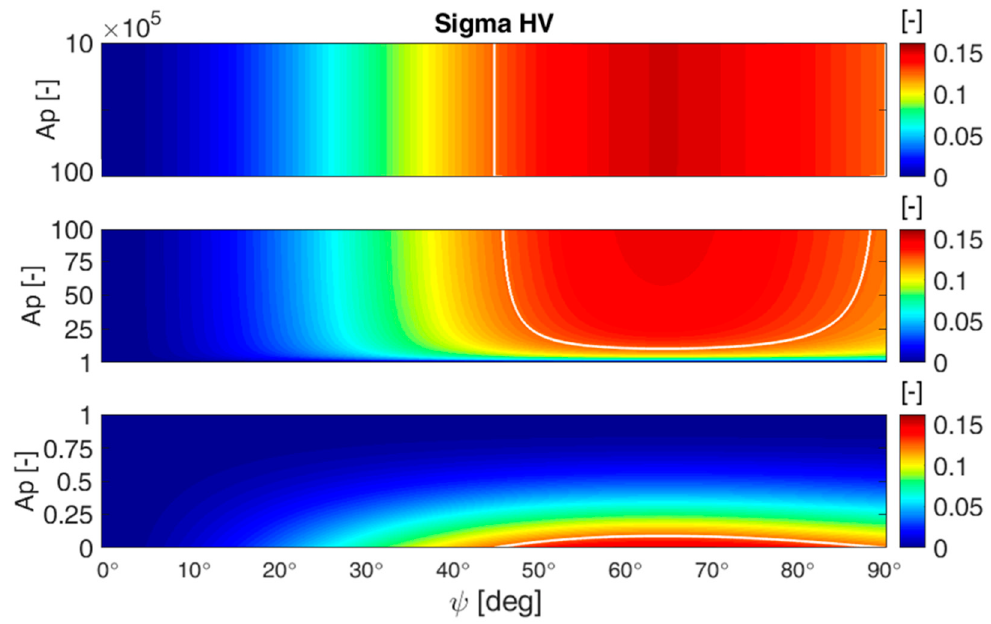
Figure 2. Density plot of modelled σ HV -values [-] from (4) as a function of vegetation parameters ψ [rad] (orientation distribution width = degree of orientation in canopy) and Ap (particle anisotropy = plant shape) [-]. The white line indicates the maximum of modelled σ HV -values (0.125) that can be normalized by the standard pre-factor of 8 in (1). The three panels correspond to different ranges of Ap (0–1; 1–100; 100–10 6 ).